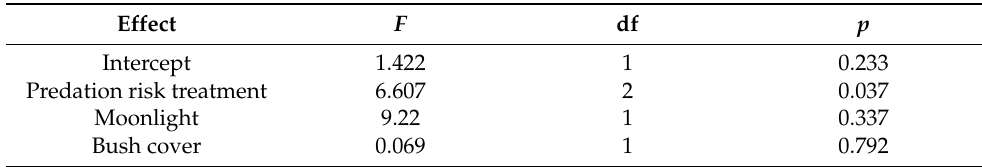
Figure 3. ( a ) Mean fast locomotor activity (s), and ( b ) mean vigilance time (s) ± SE displayed by O. longicaudatus depending on predation risk: G. nana calls (GN)/ S. rufipes calls (SR)/No vocalizations (NV). Number of events are in parenthesis. Table 7. Results of the GLM analyzing the effect of experimental and environmental factors on O. longicaudatus slow locomotor activity.